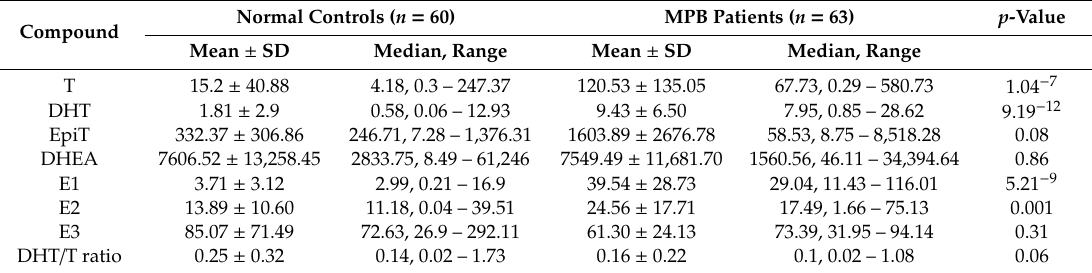
Table 1. Concentration of four androgens and three estrogens in urine samples from patients with pattern baldness who have been taking finasteride for one year and from healthy controls (ng/mg creatinine).